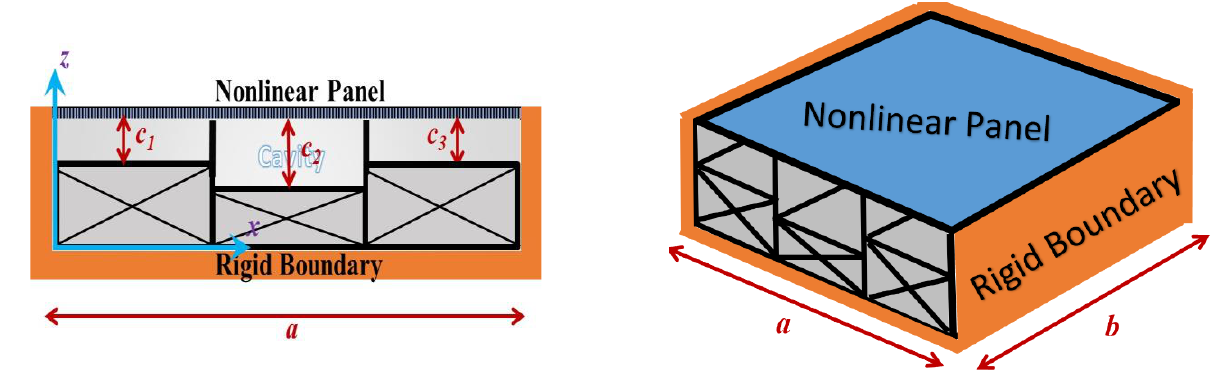
Figure 1. Nonlinear panel backed by a partitioned cavity.